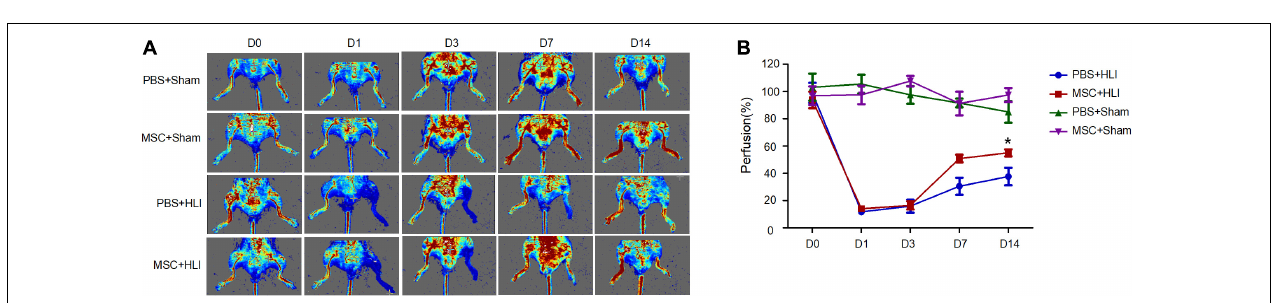
FIGURE 1 | Overexpression of mutant MetRS in MSCs allows tagging of nascent proteins in the cells in vitro and in vivo . (A) FACS analysis of mutant MSCs by the detection of mCherry signal. (B) Mutant or control cells were treated with or without ANL followed by FUNCAT analysis. Scale bar, 20 µ m. (C) Gastrocnemius muscles in HLI and Sham group transplanted with mutant cells or PBS were collected and processed for FUNCAT analysis. Scale bar, 50 µ m.